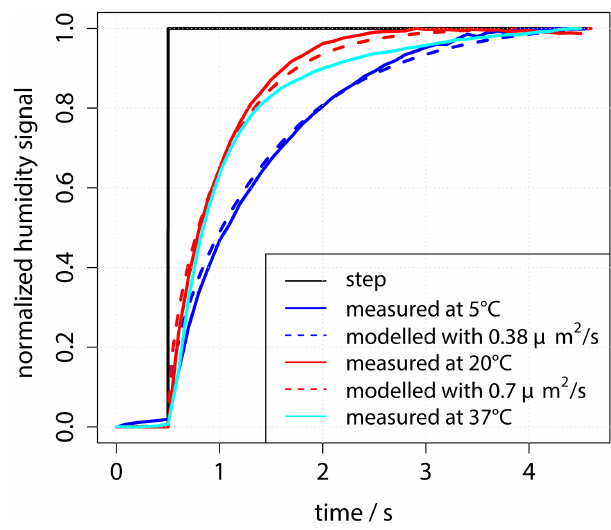
Figure 6. Step responses of the same sensor at different tempera- tures. The y axis is normalized to 0 for humidity before the step and 1 for humidity after the step. This is legitimate since the dynamics does not depend on the step